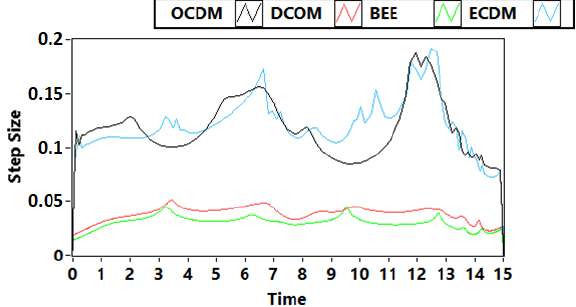
Figure 5. Step size behavior for different controllers under investigation while simulating Rössler system.